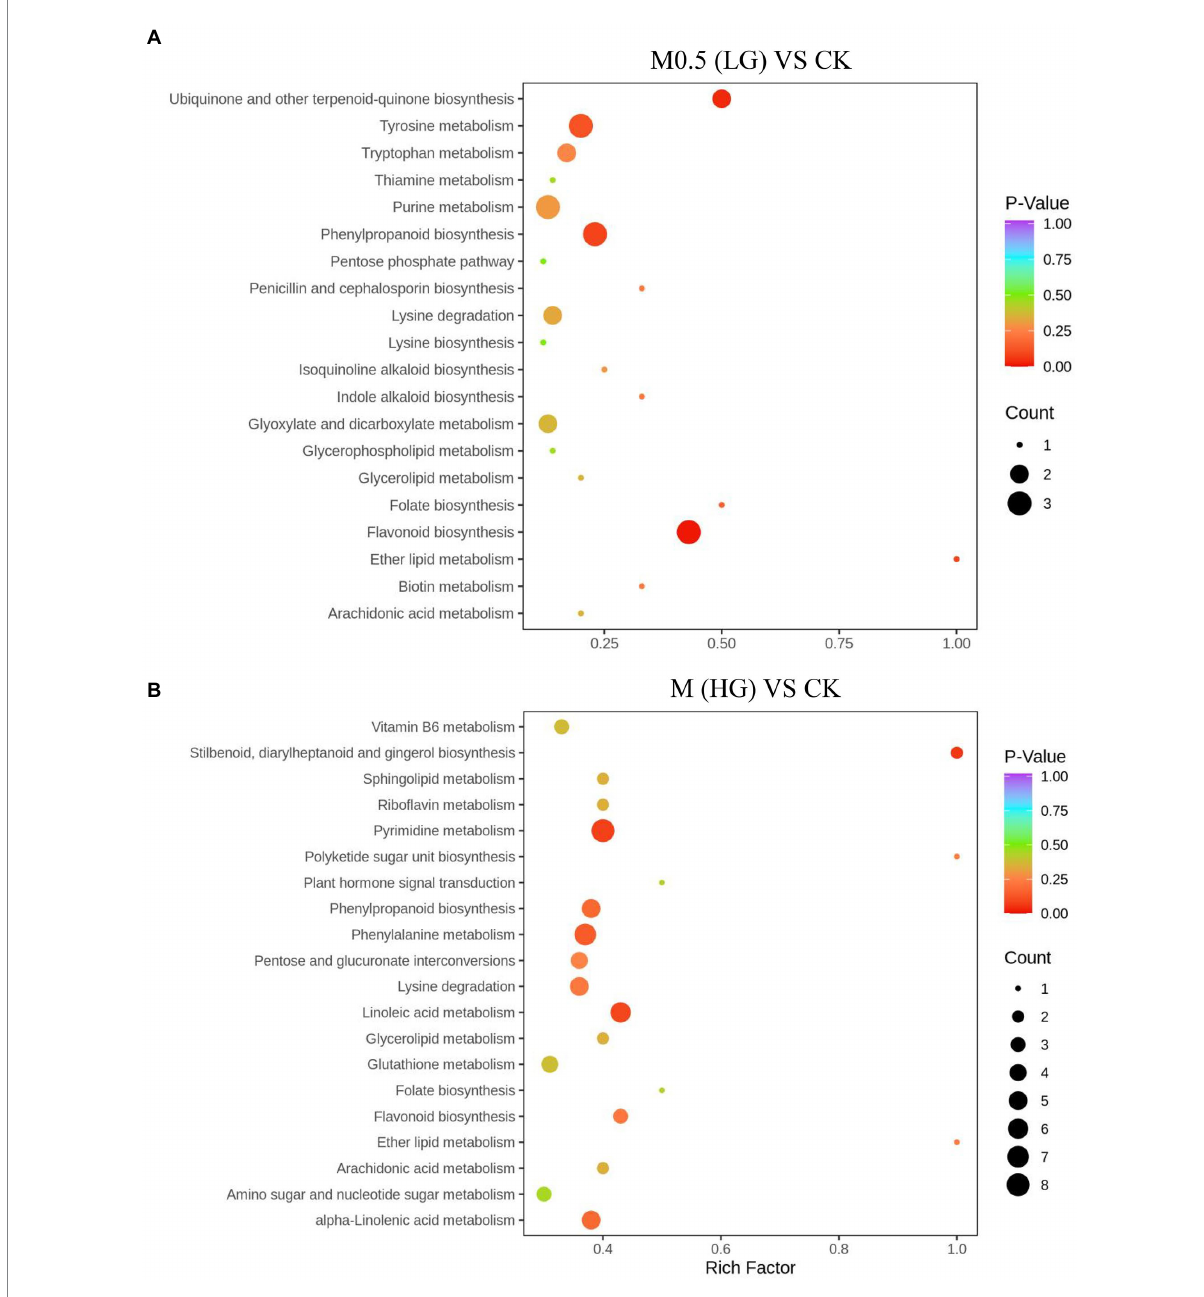
FIGURE 4 Top 20 enrichment pathways of DAMs from KEGG analysis. The two comparison groups were the DAMs of M0.5 (LG) compared with the control group (A) and M (HG) compared with the control group (B) . The X-axis is the rich factor, and the Y-axis represents the name of the pathway. The bubble size represents the number of DAMs involved. The bubble color indicates the enrichment degree of the pathway. All treatments are consistent with the